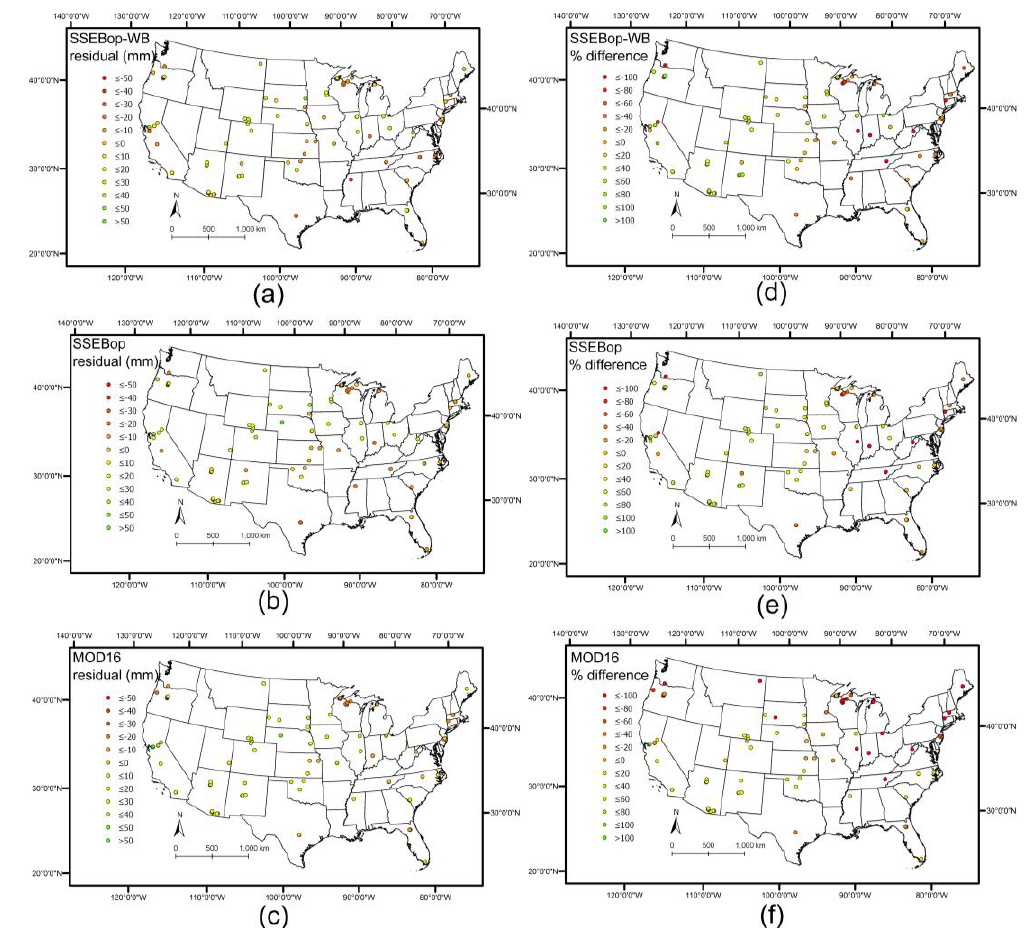
Figure 10. Residuals plotted as magnitudes of the average monthly difference between the three tested methods and the AmeriFlux tower data, for: ( a ) The SSEBop-WB ET; ( b ) The SSEBop ET; and ( c ) The MOD16 ET. The residuals are also plotted as percent differences between the three methods and the AmeriFlux tower data, for: ( d ) The SSEBop-WB ET; ( e ) The SSEBop ET; and ( f ) The MOD16 ET.